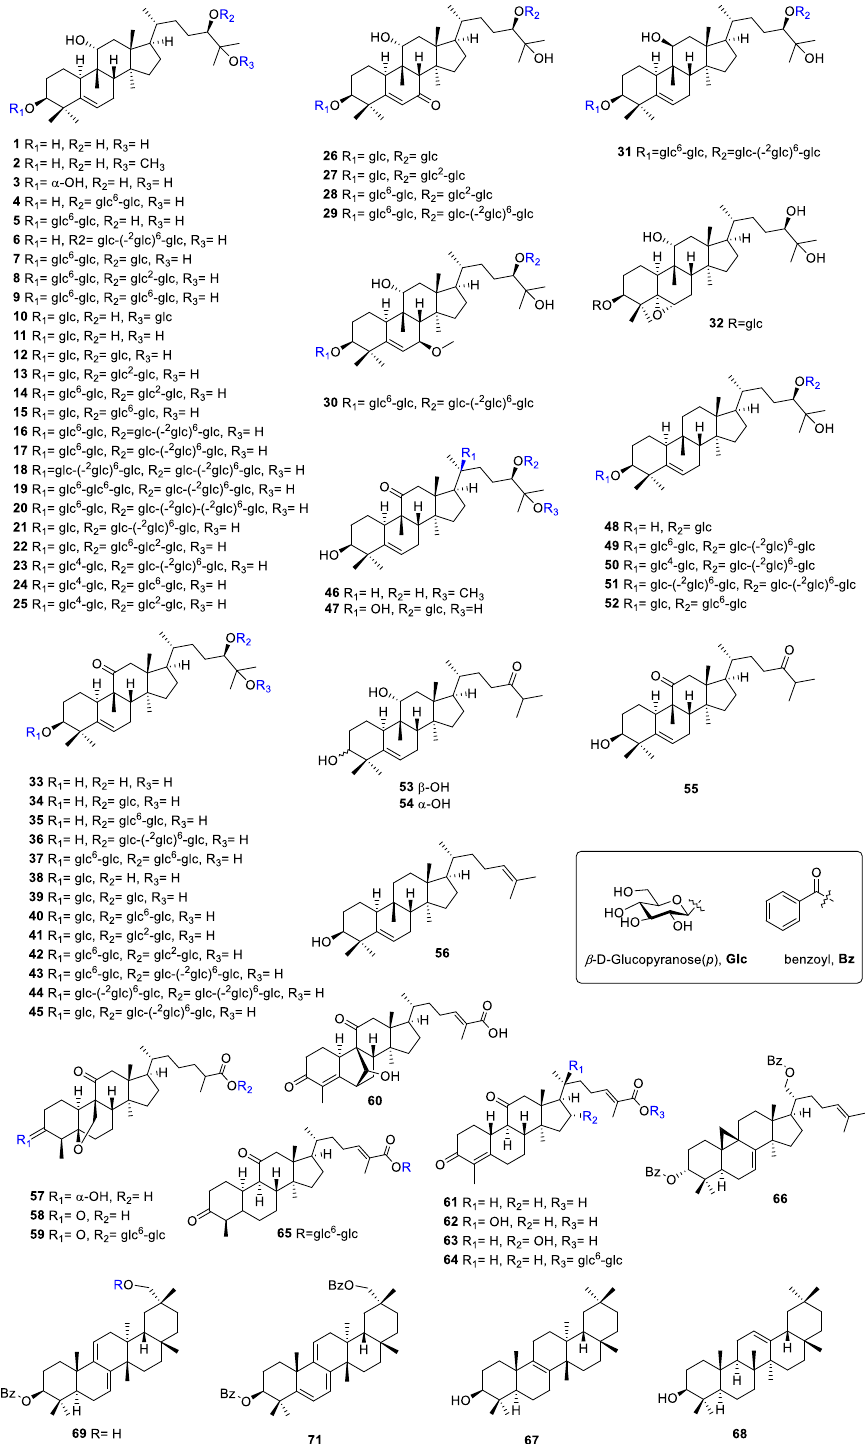
Figure 4. The structures of triterpenoids from S. grosvenorii .